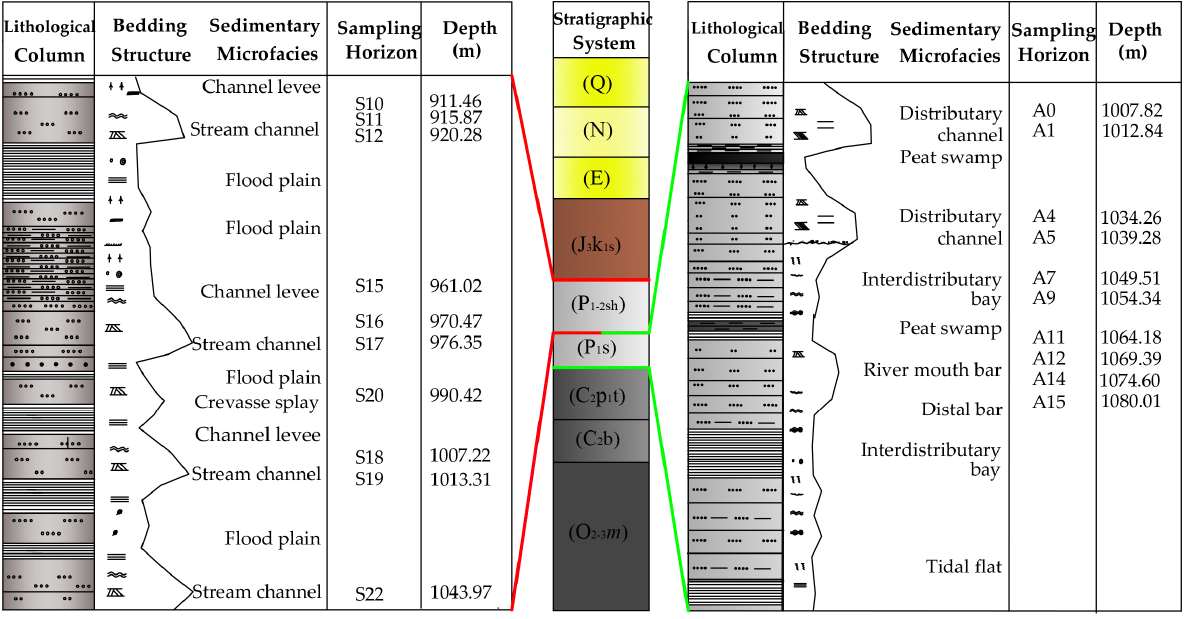
Figure 2. The sampling horizons and depths of the Permian Shihezi (P 1–2 sh) and Shanxi Formation (P 1 s) sandstone collected from the Anju coal mine of the Southwest Shandong coalfield: The gray column on the left shows the stratigraphic texture of P 1–2 sh in detail; The gray column on the right shows the stratigraphic texture of P 1 s in detail; The colored column in the middle shows the overall stratigraphic structure of the Southwest Shandong coalfield.